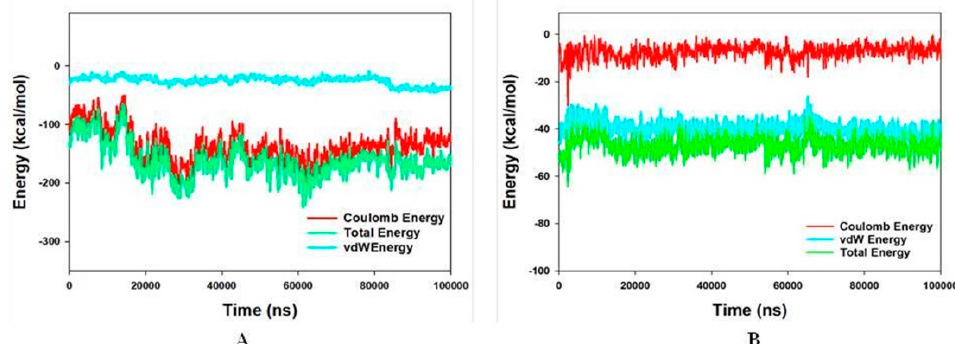
Figure 18. Energy plot of protein ALK with; ( A ) 172 complex system during the entire simulation event of 100 ns; ( B ) 178 complex system during the entire simulation event of 100 ns. The total energy (light green), van der Waal’s energy (cyan) and coulomb energy (red) of the entire system indicating the stability of the individual systems bound to molecule. Thus, MM-GBSA calculations resulted from MD simulation trajectories that were well justified with the binding energy obtained from docking results. Furthermore, the last frame (100 ns) of MMGBSA displayed the positional change of the 172 and 178 as compared to the 0 ns trajectory, indicating the better binding pose for best fitting in the protein’s binding cavity (See Figure 19).